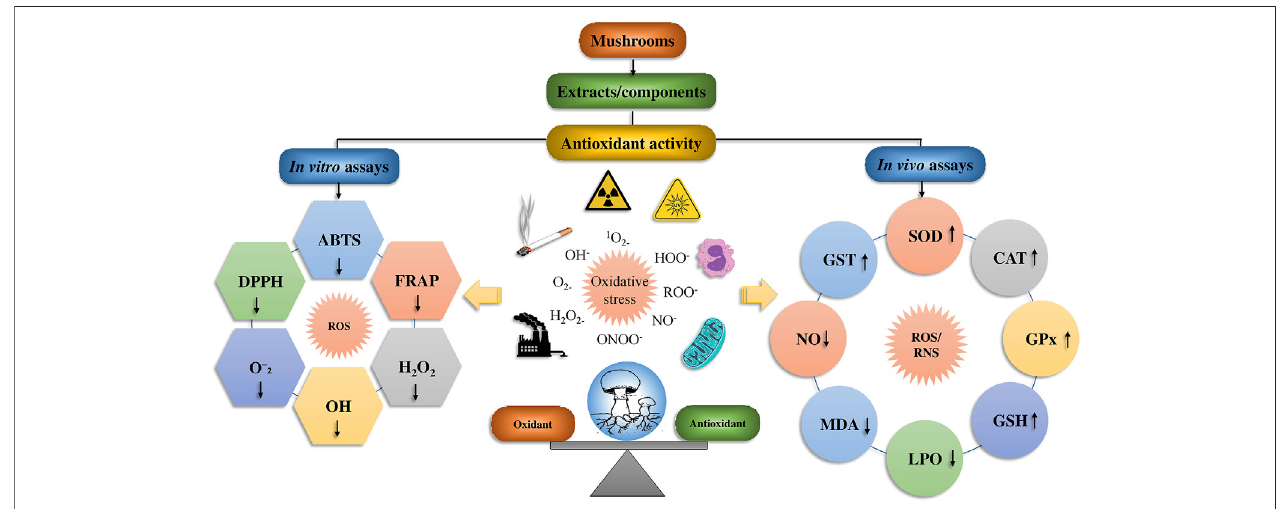
FIGURE 6 | The biomechanics of the mushroom ’ s antioxidant effect and its bioactive mushrooms